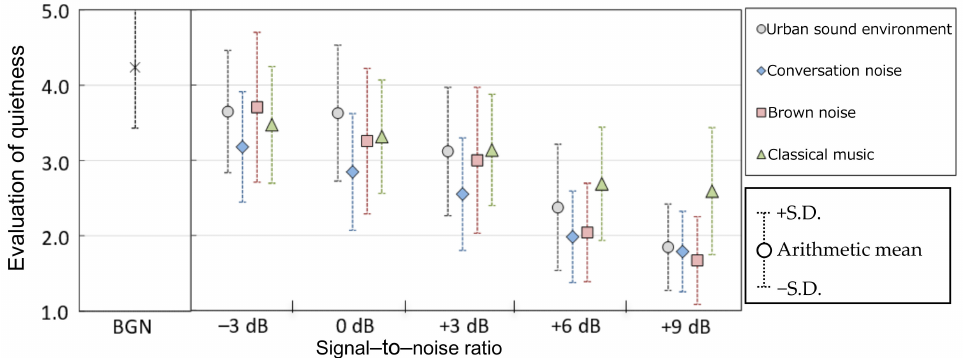
Figure 3. Evaluation of “quietness” for each sound environment condition. The plots in this figure represent the arithmetic mean, and the error bars indicate the standard